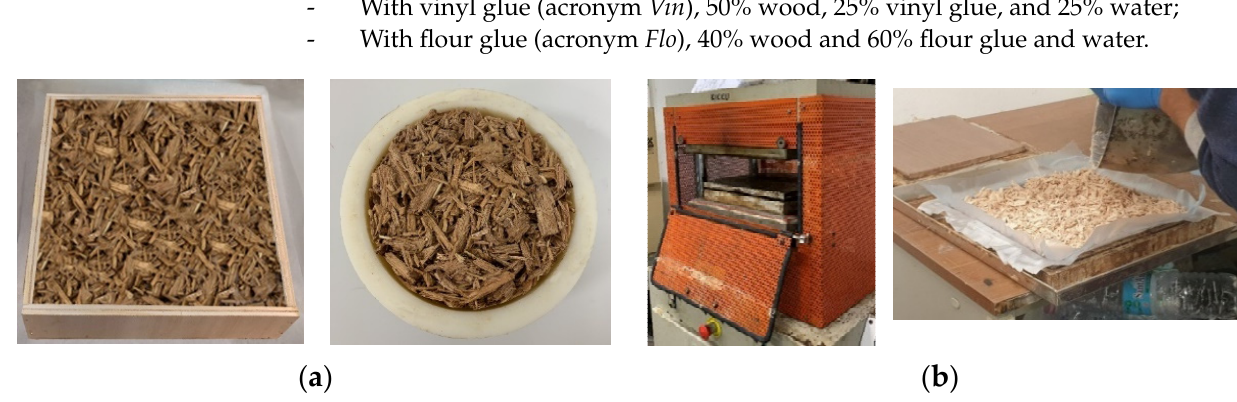
Figure 2. Assembling of the panels by hand ( a ) and hot press device ( b ). Different shapes and sizes molds were used, in order to fabricate square (300 × 300 mm 2 dimensions) and cylindrical (100-mm diameter) samples for thermal and acoustic charac- terization, respectively. Moreover, pine wood, which accounts for about 70% of the total production of the company, was mixed also with olive wood from the pruned branches, very present in the Umbrian territory, for fabricating samples with 10% of olive wood waste and 90% of pine, hand-assembled both with vinyl and natural glue. These samples were appointed P+OL, in order to highlight the presence of olives